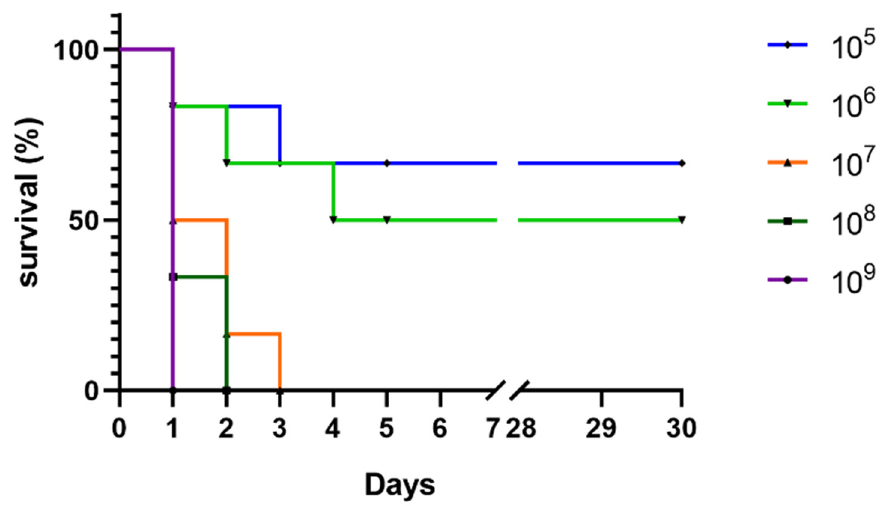
Figure 3. Female Kun Ming (KM) mice were challenged intraperitoneally with 5 × 10 5 –5 × 10 9 CFU (colony-forming units) of bacteria. Mice survival 30 days after infection is shown; the mortality rate of the strain used was at 50% during the experimental period.